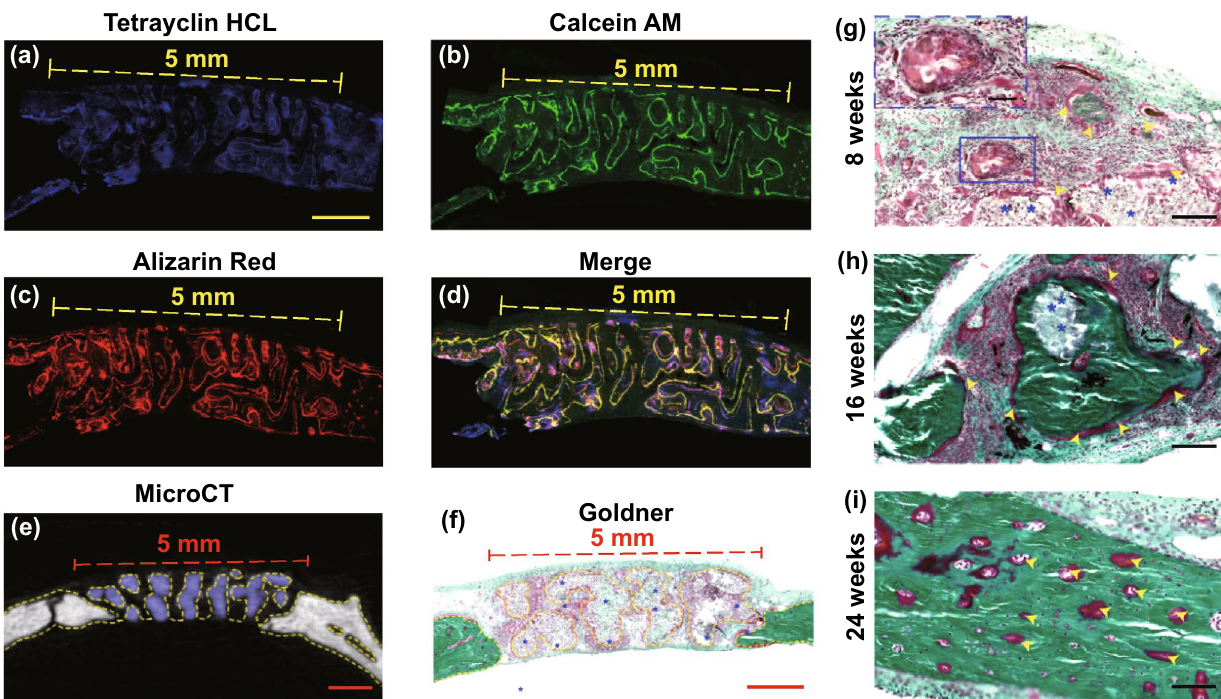
Fig. 7 Material-guided bone regeneration of NBGS in vivo. a – d Confocal fluorescence images of the newborn osseous tissues in the circular defect regions were recorded at week 8. e Transverse view of micro-CT image of harvested craniums. Purple area marks the undegraded scaf- fold. Yellow dotted line marks the location of the new bone. f Goldner trichrome staining of NBGS group at week 8, with yellow dotted line indicating the area where newborn bone tissue grows. Blue asterisks mark the residual materials. g–i Goldner trichrome staining of the regener- ated tissue in NBGS group at week 8, 16 and 24. Yellow arrow heads mark newborn osseous tissue. Blue asterisks mark the residual materials. The scale bar equals 1 mm ( a – f ) and 200 μm ( g – i